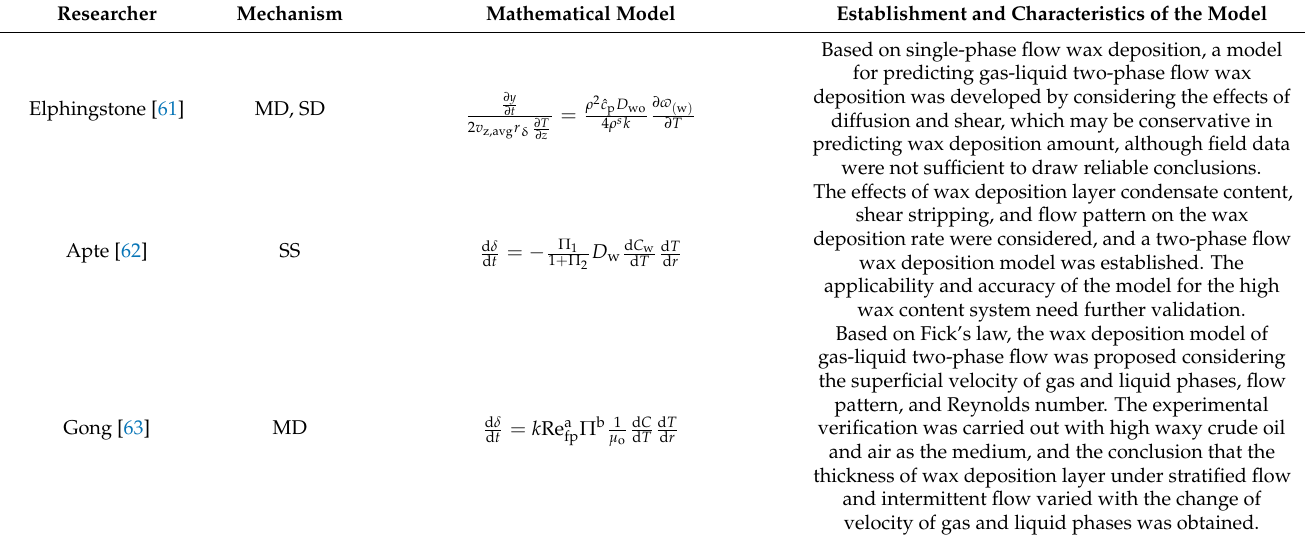
Table 2. Summary of oil-gas two-phase wax deposition